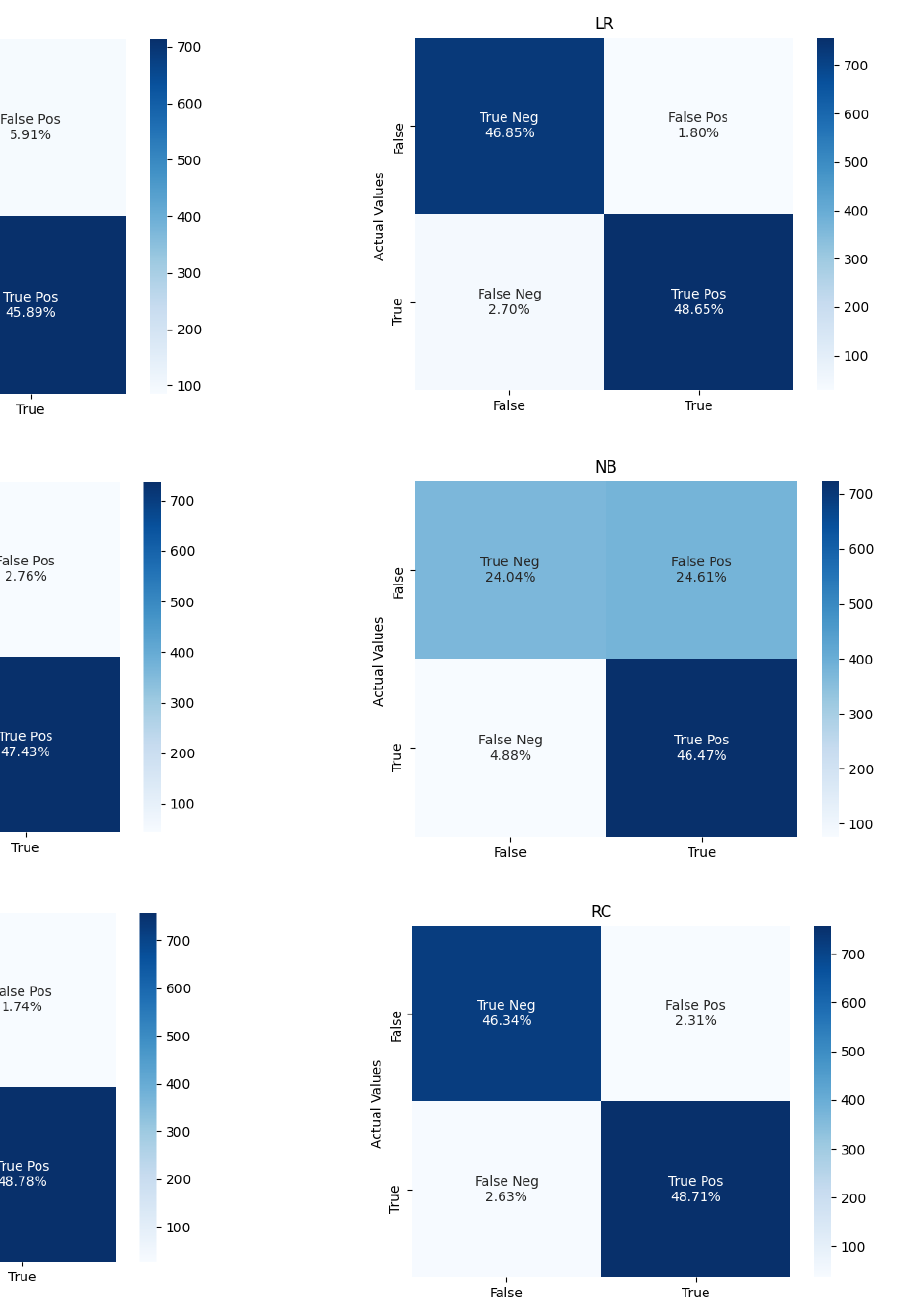
Figure 8. Confusion Matrix for Classifiers (DT, RF, SVC, LR, NB, and